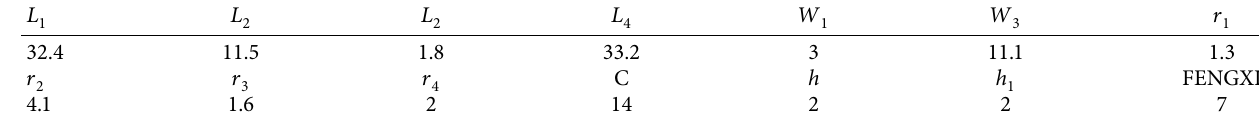
Figure 2: Antenna size diagram (all dimensions are indicated in the drawing). (a) Top view. (b) Side view. Table 1: Dimension of the CP antenna (all dimensions are in mm).